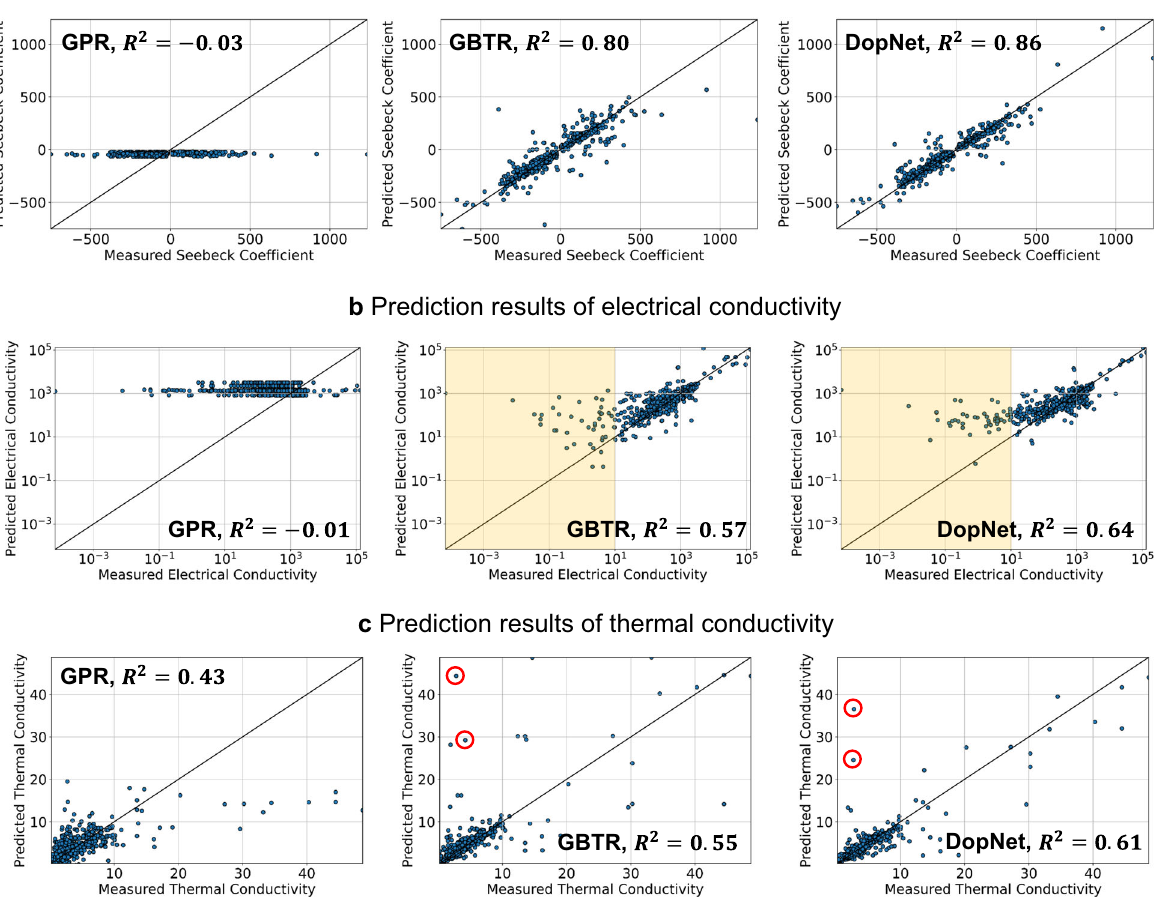
Fig. 4 Regression results of the ML algorithms in predicting Seebeck coef fi cient, electrical conductivity, and thermal conductivity. a Scatter plots of the prediction results for the test materials in predicting Seebeck coef fi cient. b Scatter plots of the prediction results with large error regions for electrical conductivity. c Scatter plots of the prediction results with large error data for thermal conductivity. The prediction results of electrical conductivity were presented by log scale. Two marked materials ( a ) and ( b ) in the prediction results of thermal conductivity are Zn 0.9975 Al 0.0025 O at 300 K and 400 K, respectively.